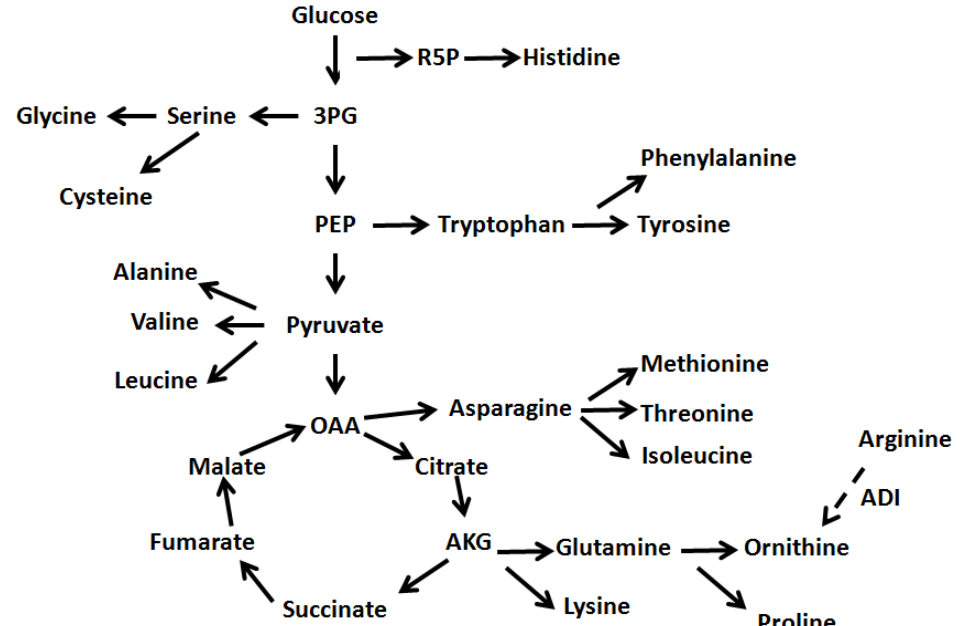
Figure 4. Schematic representation of precursor relationship between amino acids and the central carbon metabolism. R5P represents ribose -5-phosphate, 3PG represents 3-phosphoglycerate and PEP represents phosphoenol pyruvate. OAA represents oxaloacetate and AKG represents 2-oxoglutarate while ADI represents the arginine